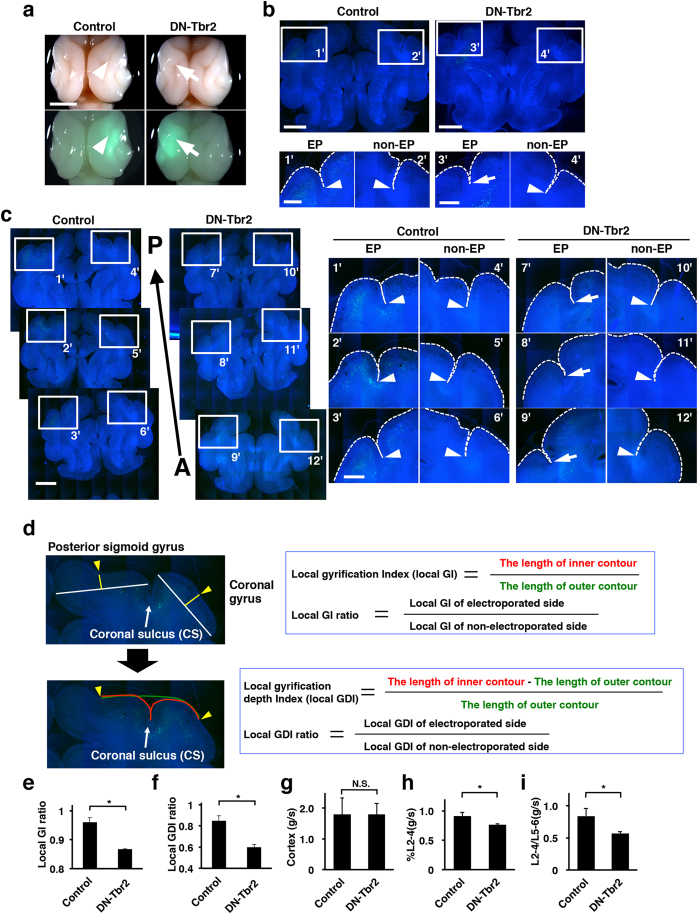
SVZ progenitors were indispensable for cortical folding.IUE was performed at E32-E33, and the brain was prepared at P16. (a) Dorsal macroscopic images. Upper panels show bright field images, and lower panels show bright field images merged with GFP images. Although the coronal sulcus was clearly formed on the control brain (arrowheads), it was obscure on the DN-Tbr2-electroporated brain (arrows). Scale bar = 5 mm. (b) Coronal sections of the brain stained with Hoechst 33342. Broken lines indicate the surface of the brain. Note that the depth of the coronal sulcus was markedly shallower on the DN-Tbr2-electroporated side of the cortex (3′, arrow) compared with that on the GFP-electroporated cortex (1′, arrowhead) and the non-electroporated side of the cortex (2′ and 4′, arrowheads). (c) Serial coronal sections of the brain stained with Hoechst 33342. A, anterior. P, posterior. Broken lines indicate the surface of the brain. (d) Quantification procedures of gyrification. (e) Quantification of the local GI ratio. The local GI ratio was significantly reduced by DN-Tbr2 (n = 3 animals; *p < 0.05; Welch’s t-test). Bars present mean ± SEM. (f) Quantification of the local GDI ratio. The local GDI ratio was significantly reduced by DN-Tbr2 (n = 3 animals; *p < 0.05; Student’s t-test). Bars present mean ± SEM. (g) The cortical thickness of the posterior sigmoid gyrus divided by that of the coronal sulcus. The thickness(g/s) values were not affected by DN-Tbr2. (n = 3 animals; p > 0.05; Student’s t-test; N.S. not significant). Bars present mean ± SD. (h) The thickness of layer 2–4 relative to the cortical thickness (%L2-4) was measured, and the ratio of %L2-4 in the posterior sigmoid gyrus to that in the coronal sulcus [%L2-4(g/s)] was calculated (n = 3 animals; *p < 0.05; Student’s t-test). Bars present mean ± SD. (i) The thickness of layer 2–4 relative to that of layer 5–6 (L2-4/L5-6) was measured, and the ratio of L2-4/L5-6 in the posterior sigmoid gyrus to that in the coronal sulcus [L2-4/L5-6 (g/s)] was calculated (n = 3 animals; *p < 0.05; Student’s t-test). Bars present mean ± SD.